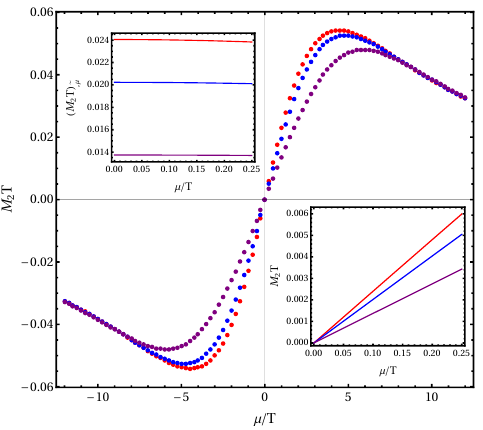
Figure 4 . The dimensionless thermodynamic susceptibility M 2 T as a function of the chemi- √ cal potential µ/T for γ = 2 / 3 . The different curves correspond to magnetic fields B/T 2 = { 0 . 05 , 12 . 5 , 30 } (red, blue,